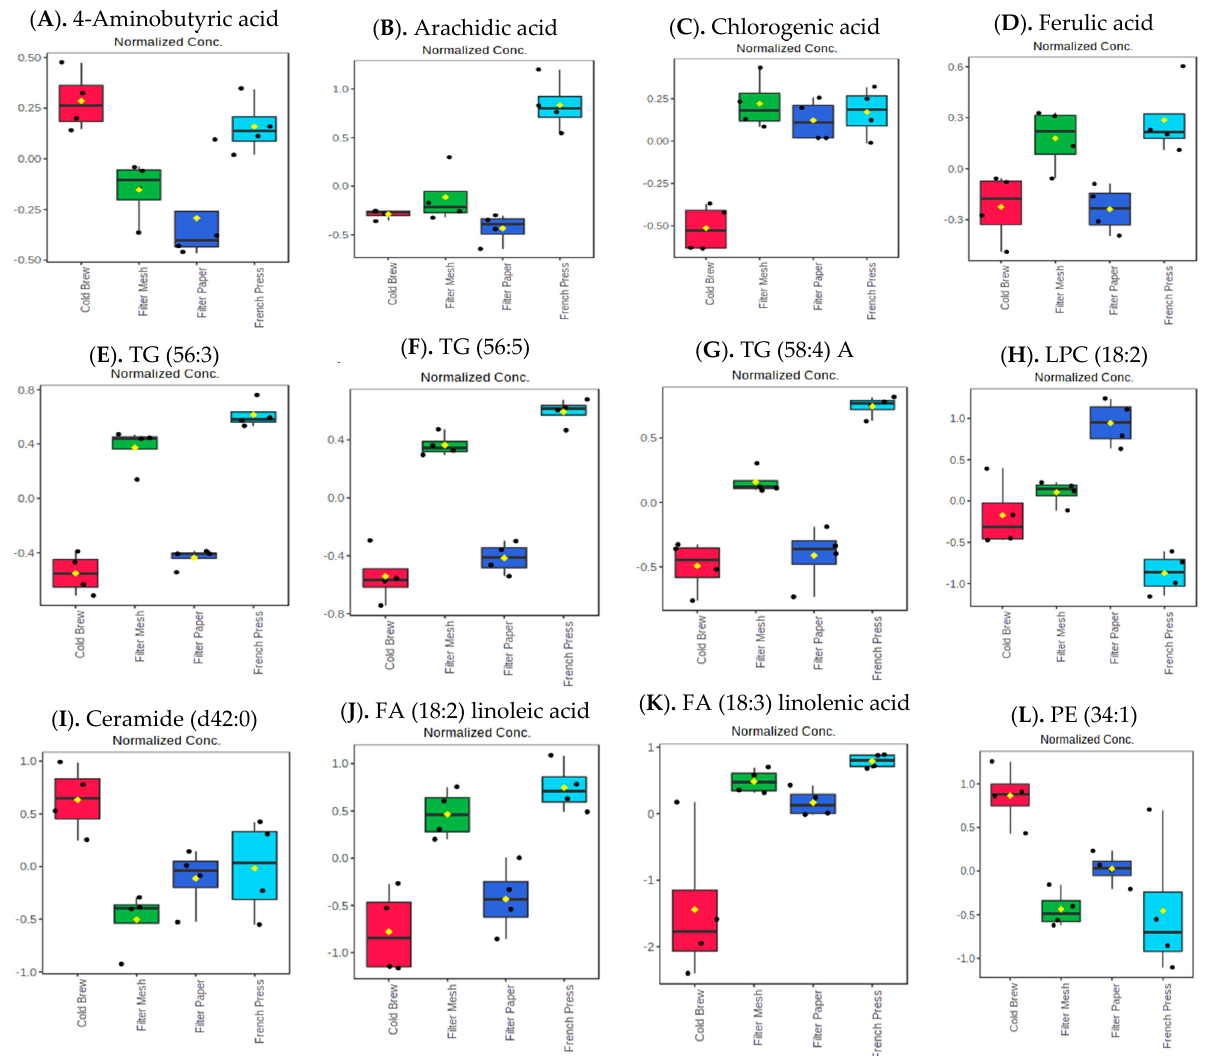
Figure 5. Relative changes of selected known metabolites ( A – D ) and positive ( F – H ) and negative ( I – L ) ESI mode lipids in different coffee brews are depicted ( n = 4, p < 0.05). TG, triacylglycerol; LPC, lysophosphatidylcholine; FA, fatty acid; PE, phosphatidylethanolamine. cold brew; fil- ter mesh; filter paper; French press.